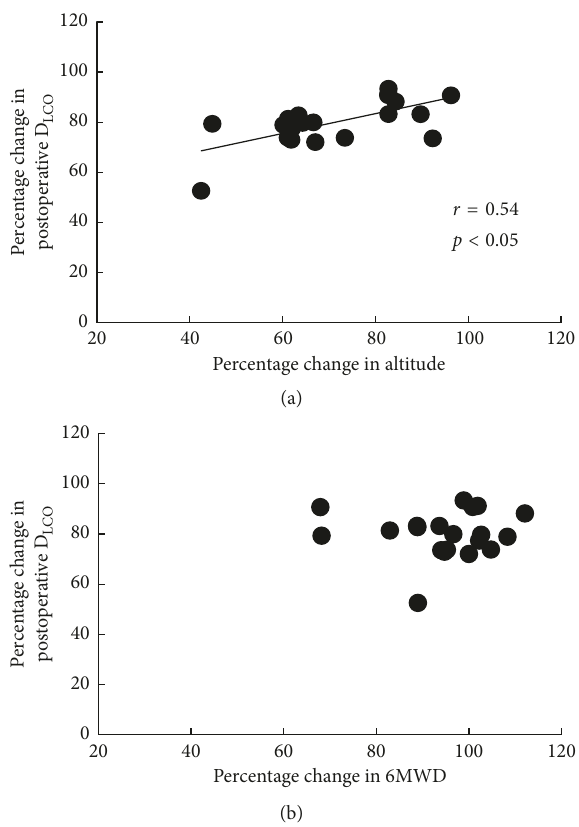
Figure 3: Correlation between percentage changes in altitude reached in the (a) stair-climbing test and (b) 6MWD and those in D LCO values at 1 month after surgery. Altitude, altitude reached in the stair-climbing test; 6MWD, 6-min walk distance; D LCO , carbon monoxide lung diffusion